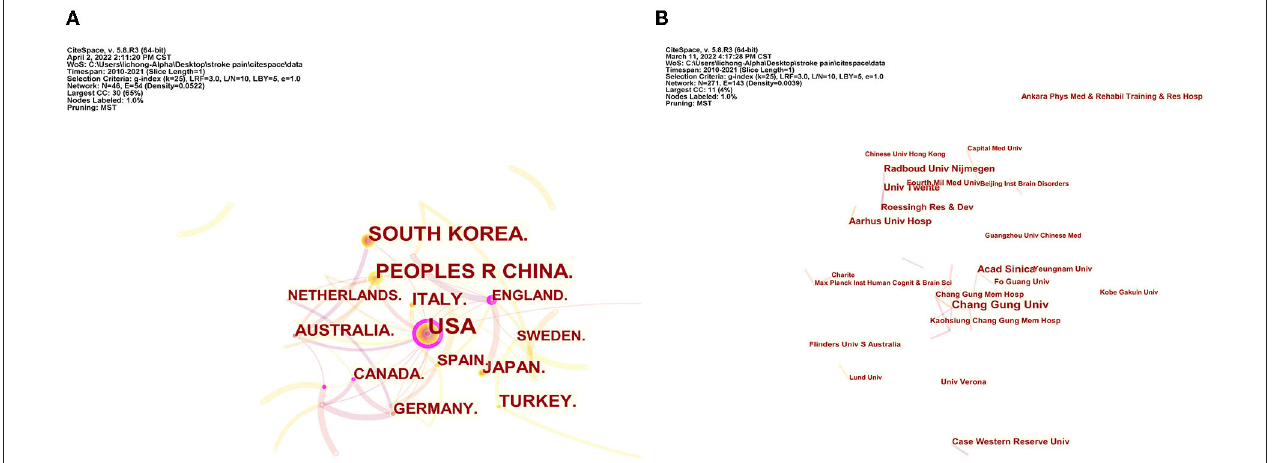
FIGURE 9 | The analysis of countries and institutions. (A) Network map of countries engaged in pain after stroke. (B) Network map of institutions engaged in pain after stroke.